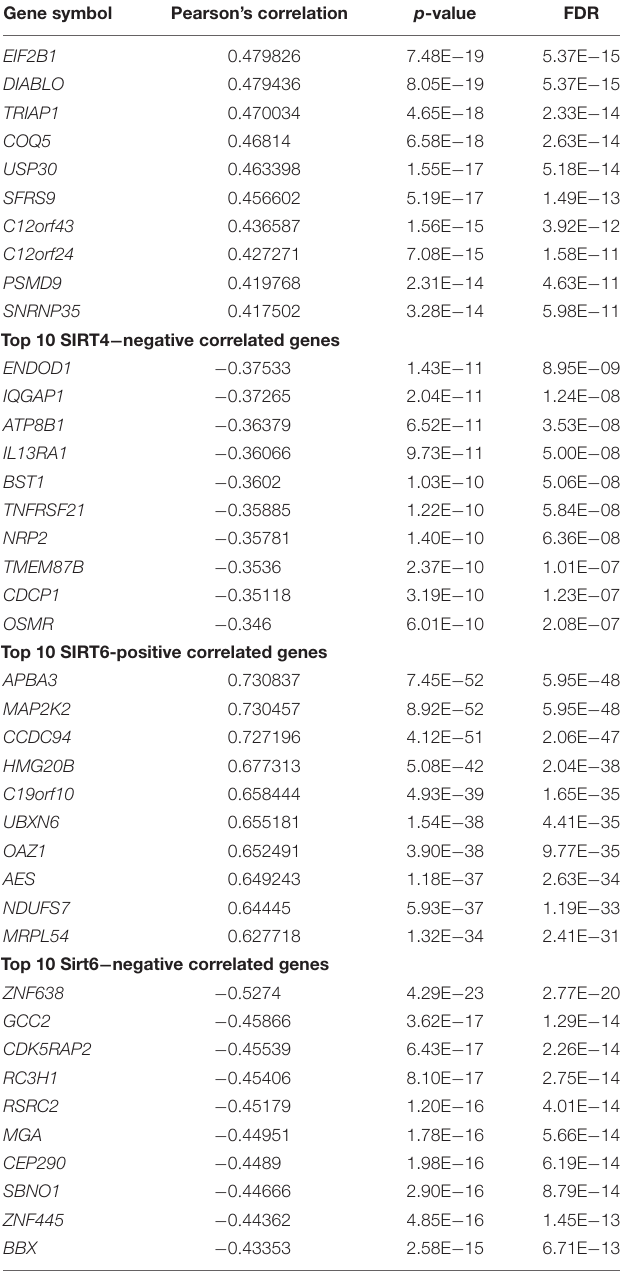
TABLE 1 | Top 10 SIRT4-positive correlated